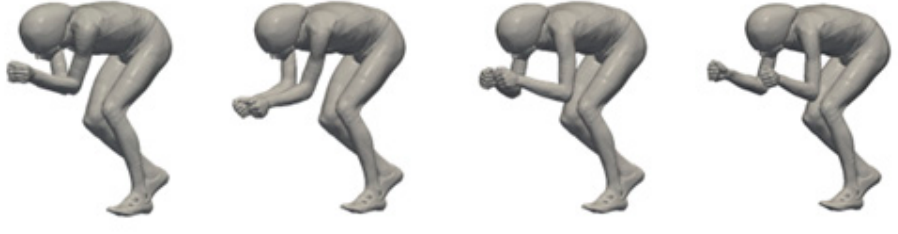
Figure 1. Illustration of the positional parameters considered. From left to right: Base position, maximum elbow extension, maximum shoulder abduction, and maximum elbow rotation and shoulder